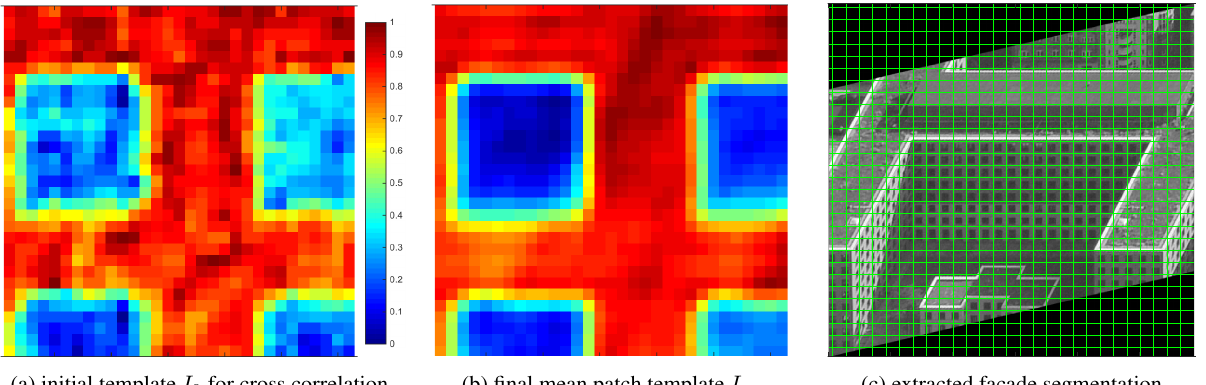
Figure 3. Process of extracting the facade regularity via cross correlation. (a) shows the initial template which is derived from the SAR lattice. The color codes the normalized gray values. (b) depicts the mean patch after the iterative procedure described in the text. A higher contrast compared to the initial patch is discernible. (c) illustrates the extracted lattice regularity. Note that the extent of the regularity is not known at this time and, therefore, is continued to the image